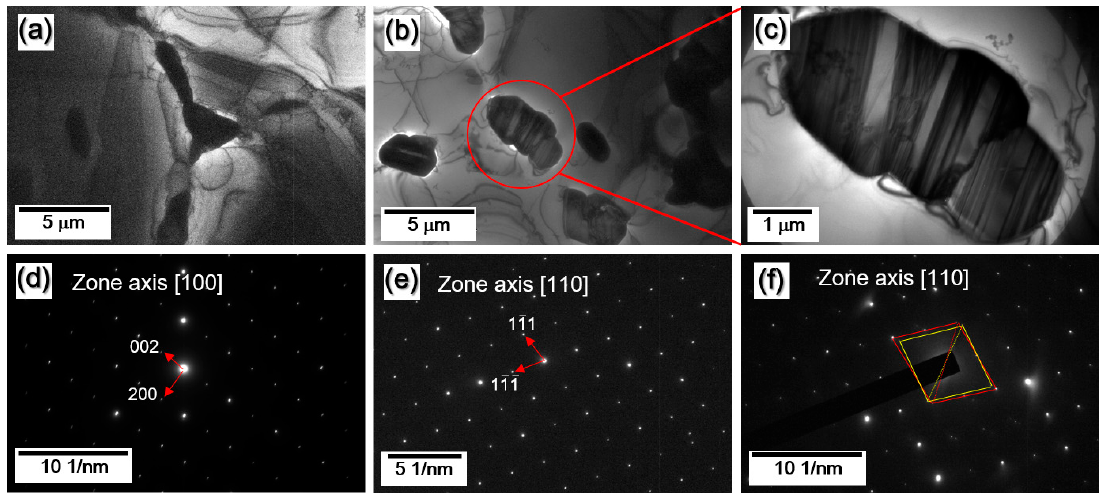
Figure 5. TEM characterization of specimen #4: ( a – c ) the precipitate near the GB, ( d – f ) the corresponding SADPs.